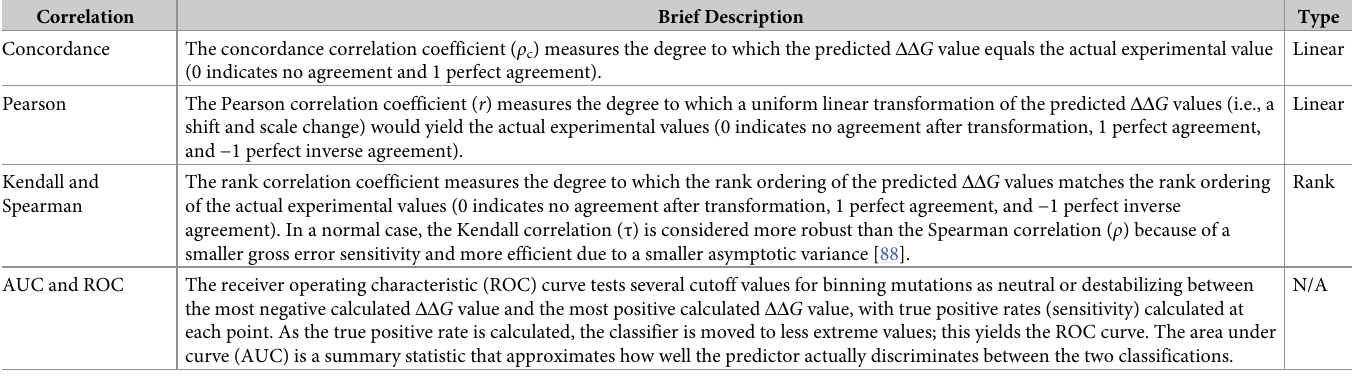
Table 3. Statistical measures used to test the performance of each method in predicting ΔΔ G values.